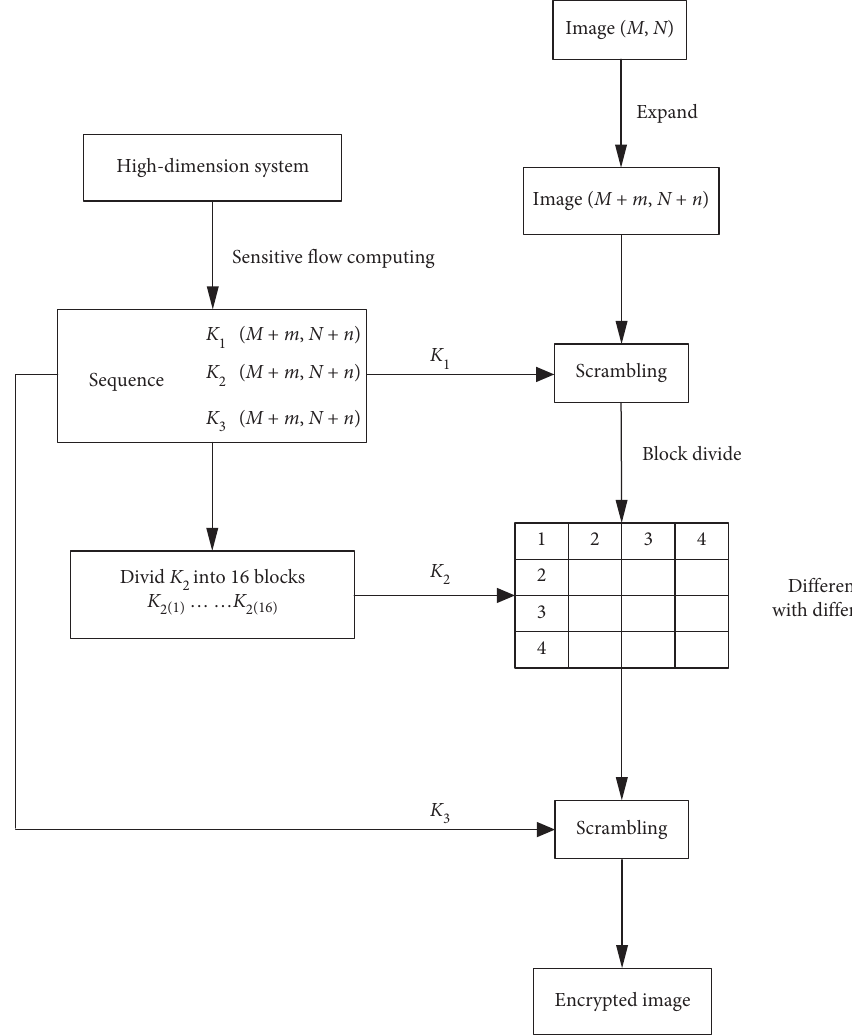
Figure 3: The encryption